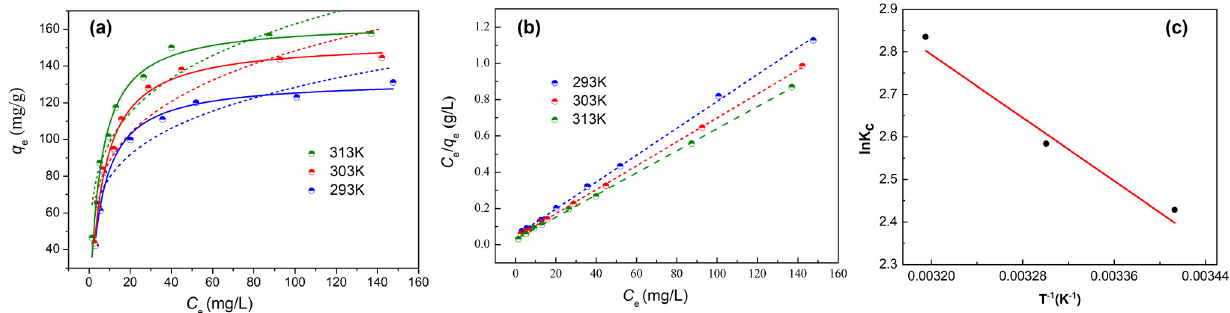
Figure 6. Adsorption isotherms of IONPs@MAH- β -CD at pH = 6.0 and 293, 303, and 313 K using the Langmuir and Freundlich model fittings ( a ), linear plot of Ce/qe versus Ce ( b ), and linear plot of lnK 0 versus 1/T ( c ) on IONPs@MAH- β -CD.